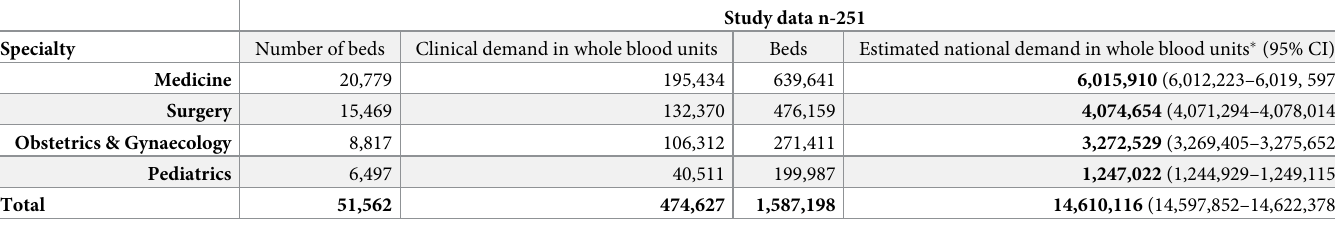
Table 2. Estimated national clinical